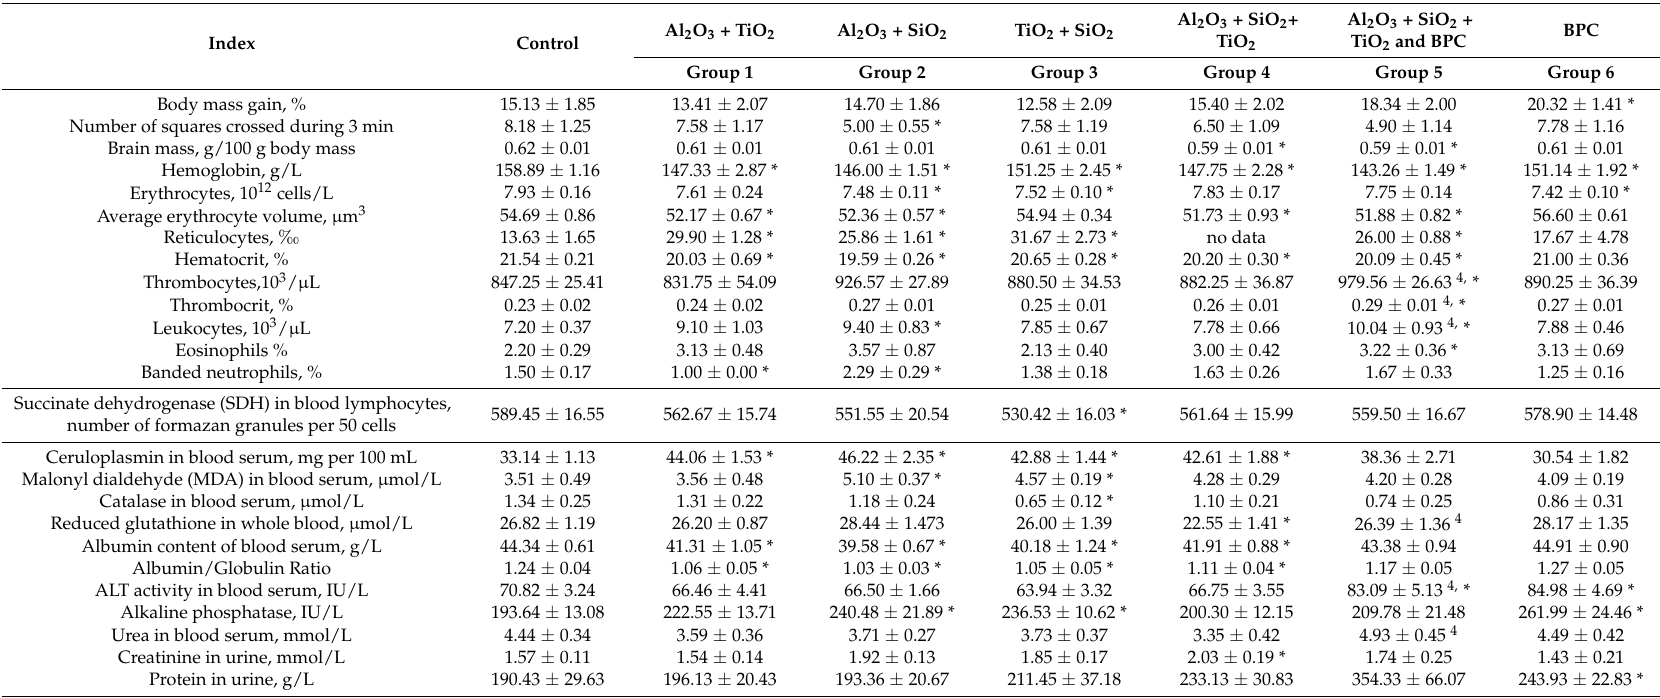
Table 3. Functional and Biochemical Indices of Rat Organism Status differing significantly from controls and/or those of other groups after 18 (during 6 Weeks) Intraperitoneal Injections of Suspensions of Various MeO-NP Species Administered in Binary or Ternary Combinations (x ± s.e.). The complete Table is given as Table S2 of Supporting